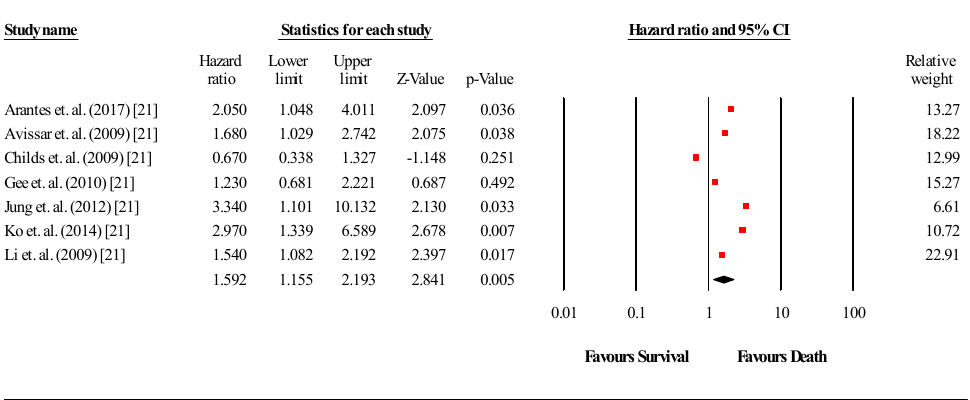
Figure 4. Forest plot for miR-21 association with OS.